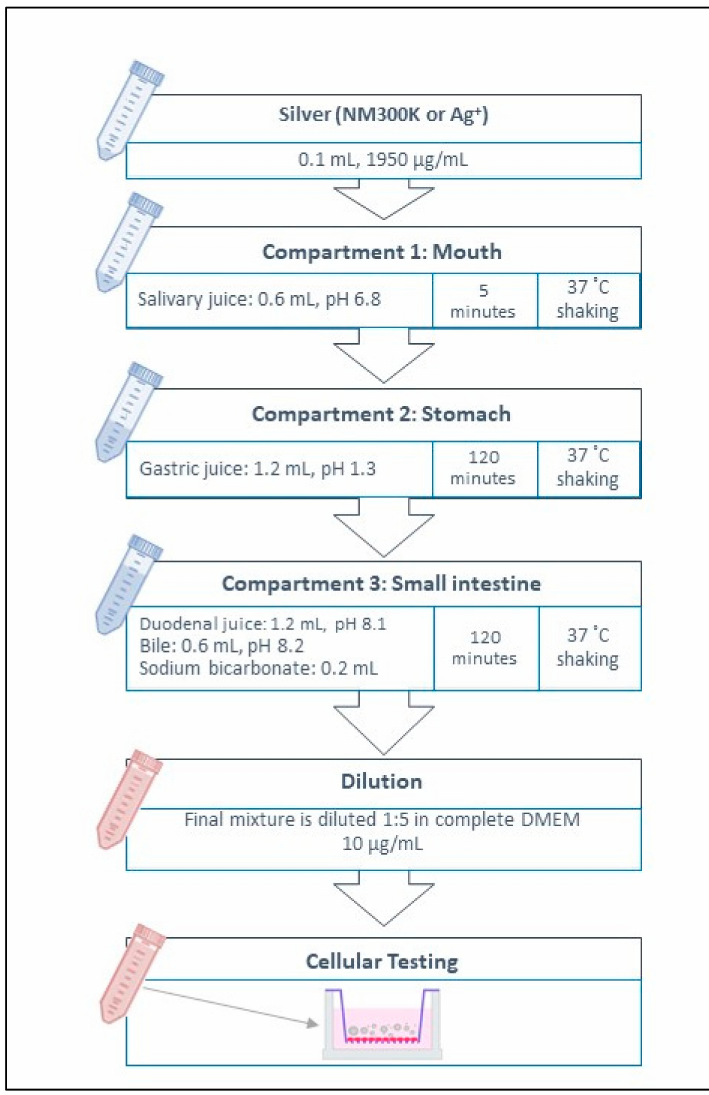
Scheme 2. Schematic process for the consecutive in vitro digestive assay showing the conditions re- quired to simulate the passage of material through the mouth, stomach, small intestinal compartments and to cellular